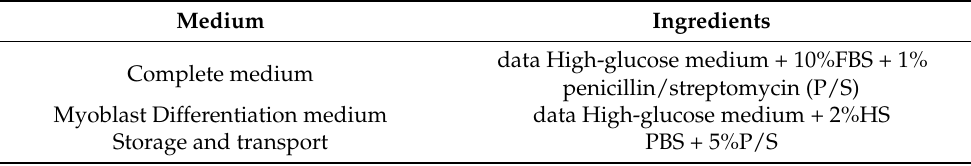
Table 1. Culture medium